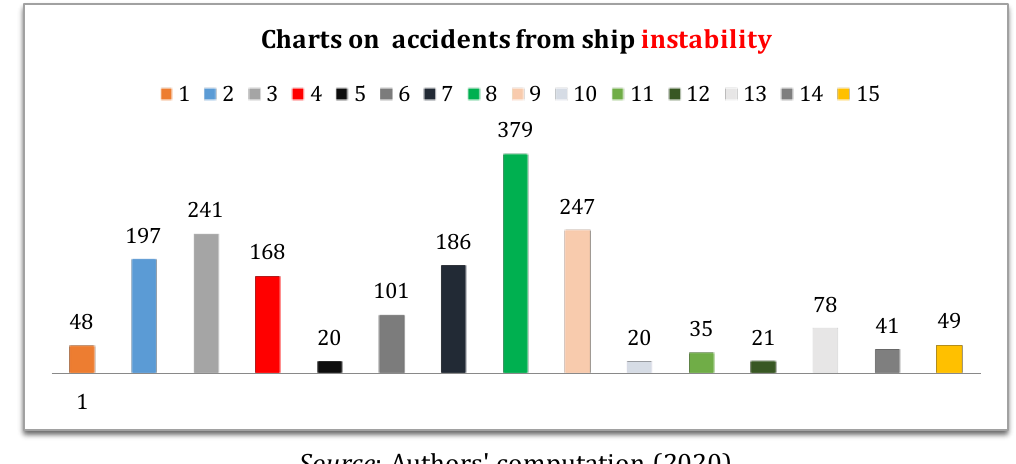
Figure 4: Histograms of accidents from boat's instability in Nigeria